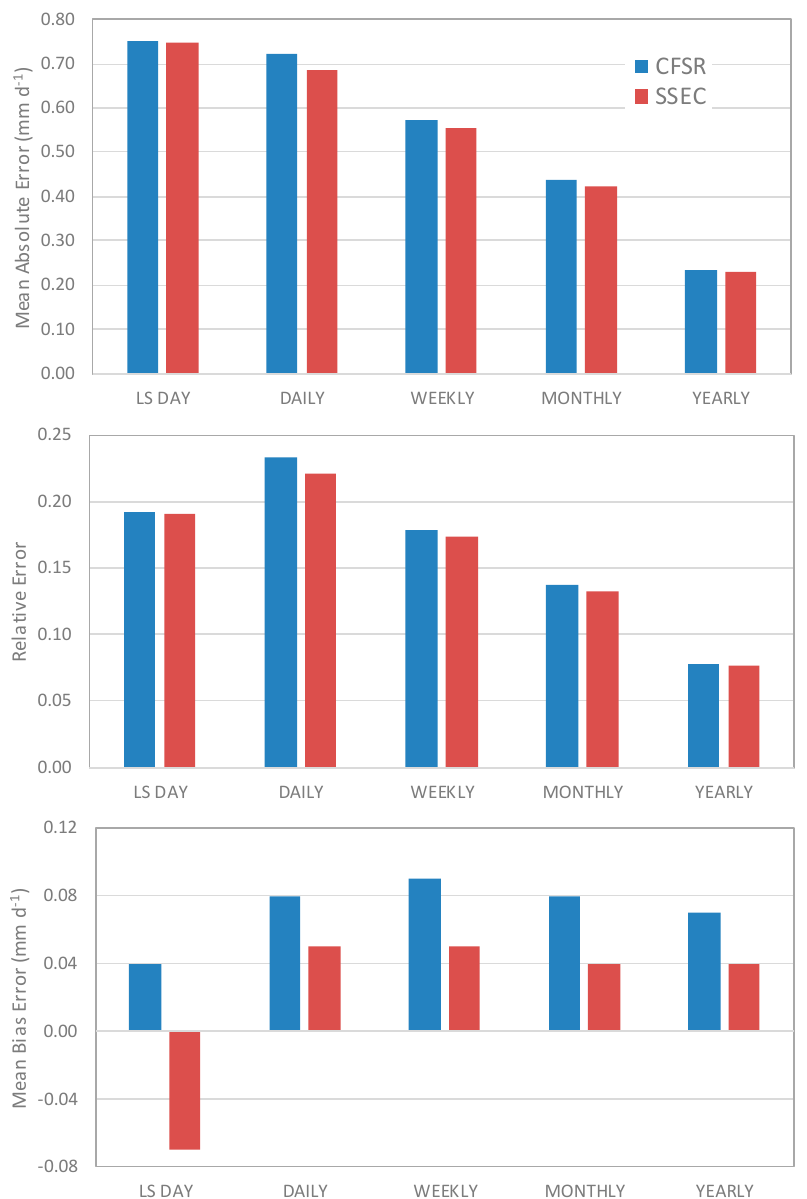
Figure 8. MAE, RE, and MBE in ET retrievals using the CFSR and SSEC insolation inputs on clear Landsat overpass dates (LS DAY) and at daily, weekly, monthly, and yearly timesteps over the study period.